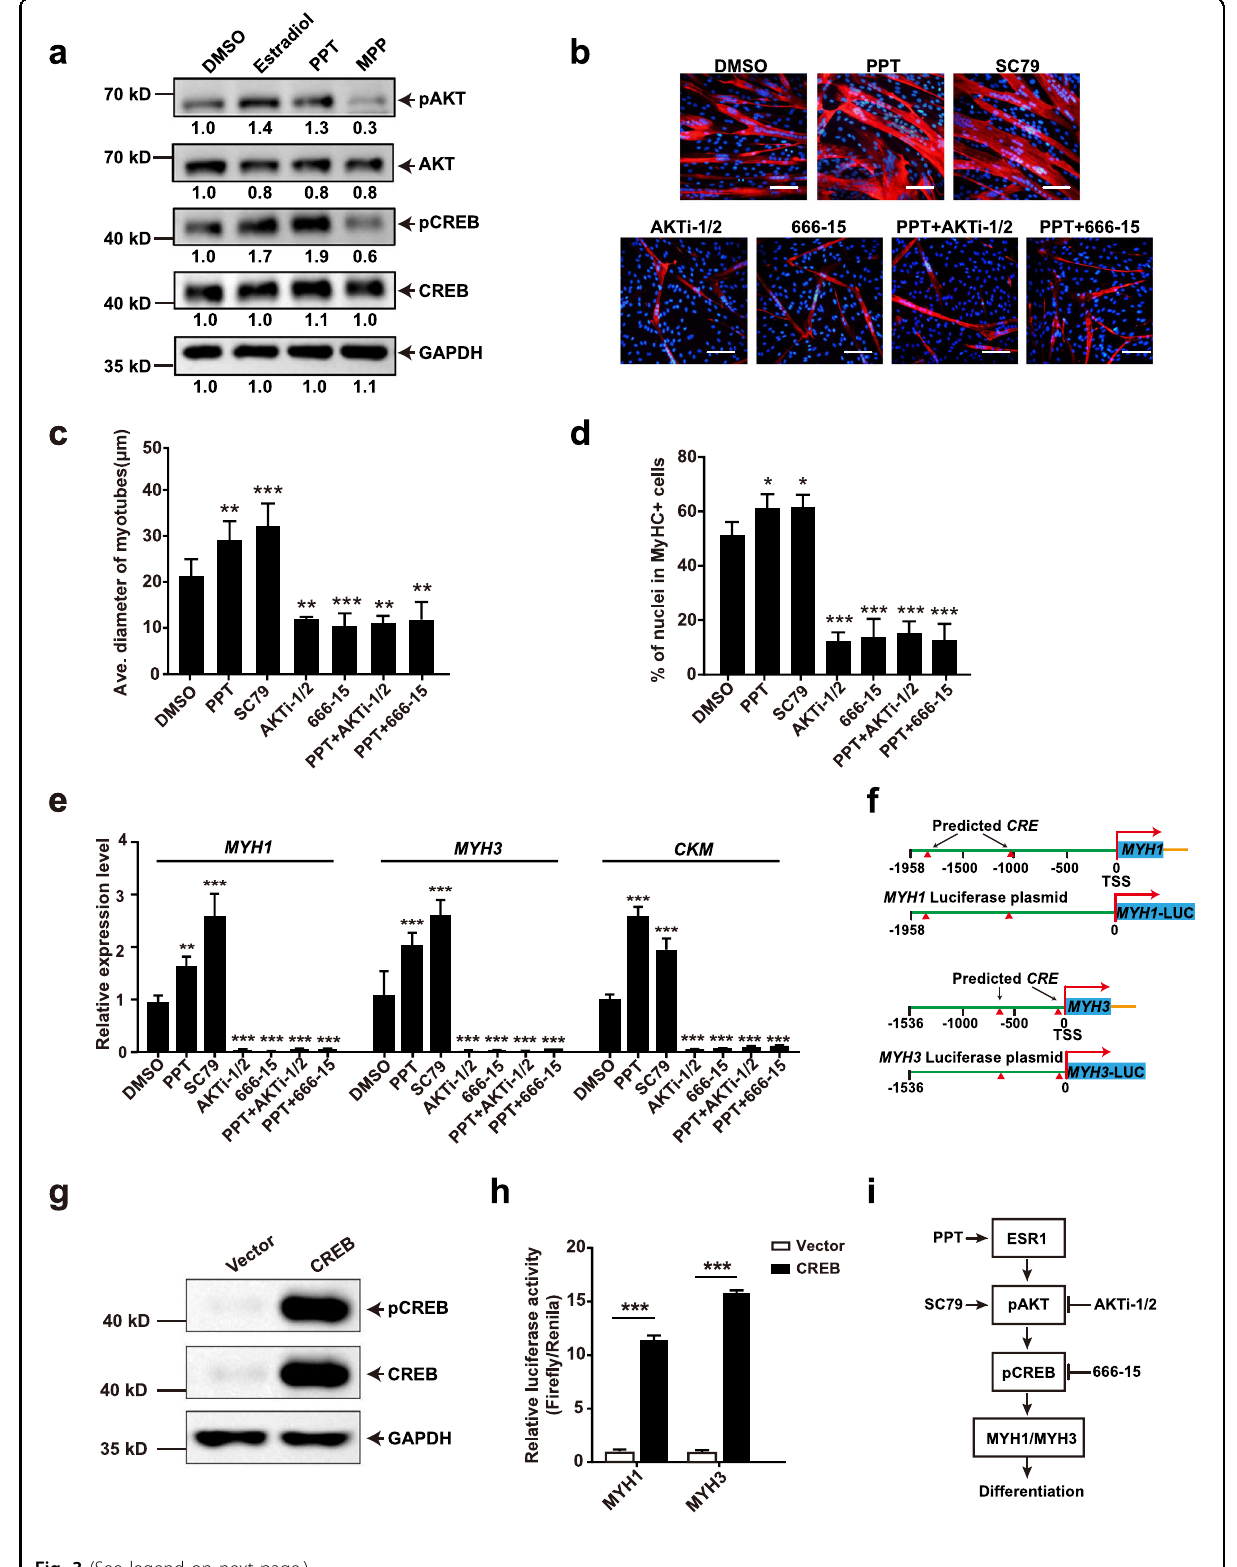
Fig. 3 (See legend on next